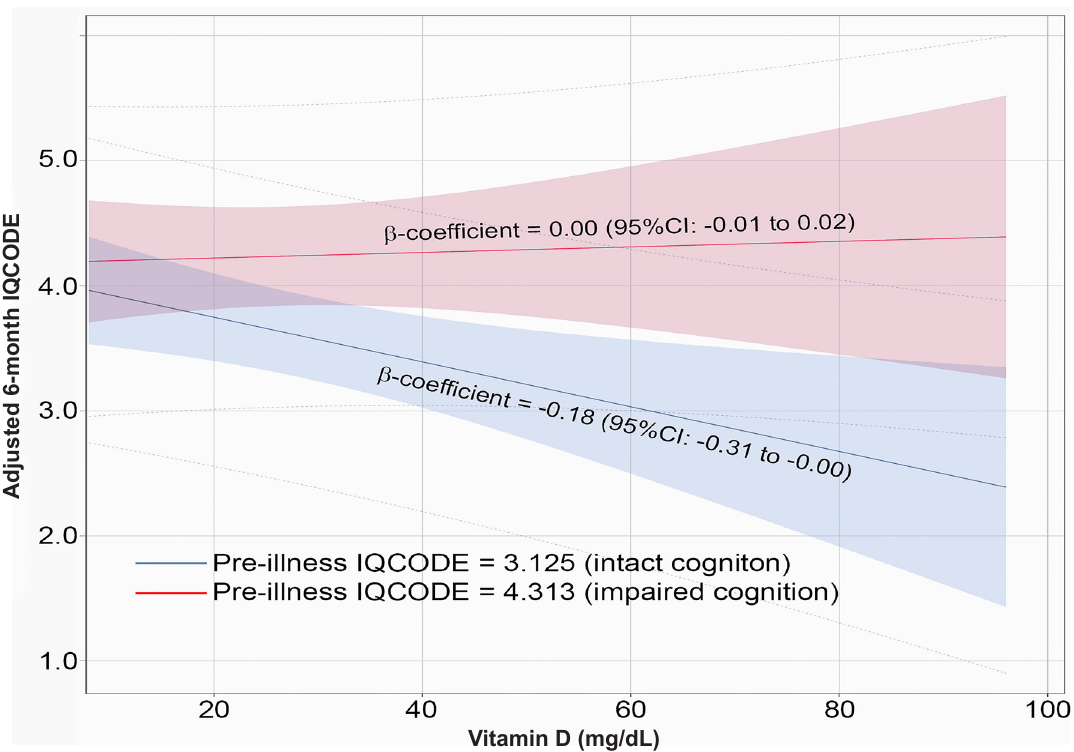
Figure. The relationship between serum Vitamin D concentrations measured at enrollment and 6-month cognition. Cognition was determined by the short Informant Questionnaire on Cognitive Decline in the Elderly (IQCODE) which ranged from 1 to 5 (severe cognitive impairment). The association between serum Vitamin D and 6-month cognition was modified by pre-illness cognition. In older adults with pre-illness cognitive impairment (higher IQCODE group, shown in RED), serum Vitamin D concentrations were not a predictor of adjusted 6-month cognition. In older adults who were cognitively intact at baseline (lower pre-illness IQCODE group, shown in BLUE), there was a statistically significant relationship between serum vitamin D concentrations and 6-month cognition after adjusting for